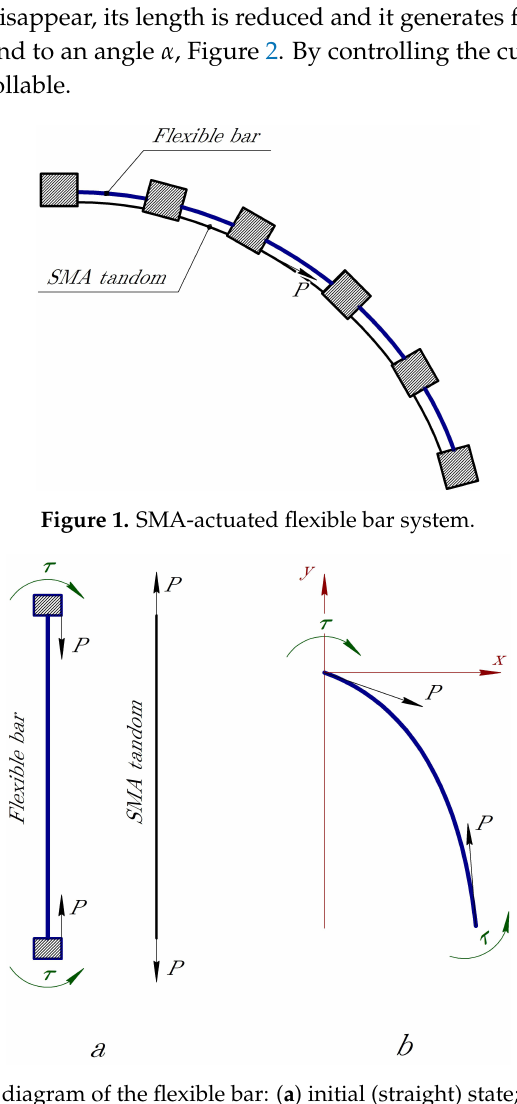
Figure 2. Free body diagram of the flexible bar: ( a ) initial (straight) state; ( b ) after